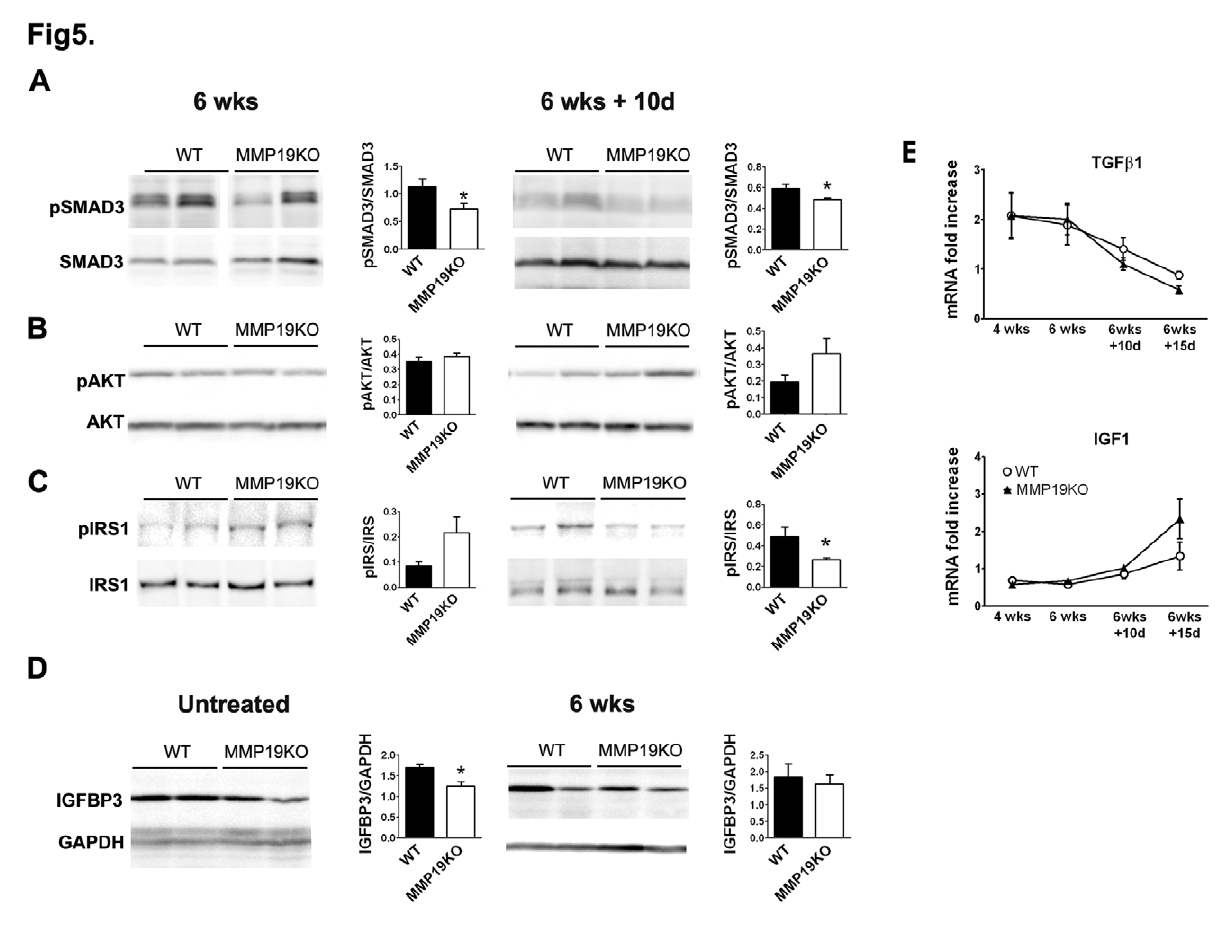
Figure 5. Analysis of TGF-ß- and IGF-1-mediated signaling pathway mediators during hepatic fibrosis and its resolution. (A–C) SMAD3 (A), Akt kinase (B) and IRS1 (C) phosphorylation was analyzed by immunoblotting liver lysates of treated and control animals. (D) IGFBP3 protein expression was significantly lower in untreated MMP19KO than in WT livers. (E) qRT-PCR analysis showed slightly higher IGF-1 and slightly lower TGF-ß1 mRNA levels in MMP19KO livers than in WT livers during fibrosis resolution. *p , 0.05, MMP19s vs. WTs. 4–7 mice from each strain were analyzed at each time point. In some instances, noncontiguous lanes from one Western blot are shown.